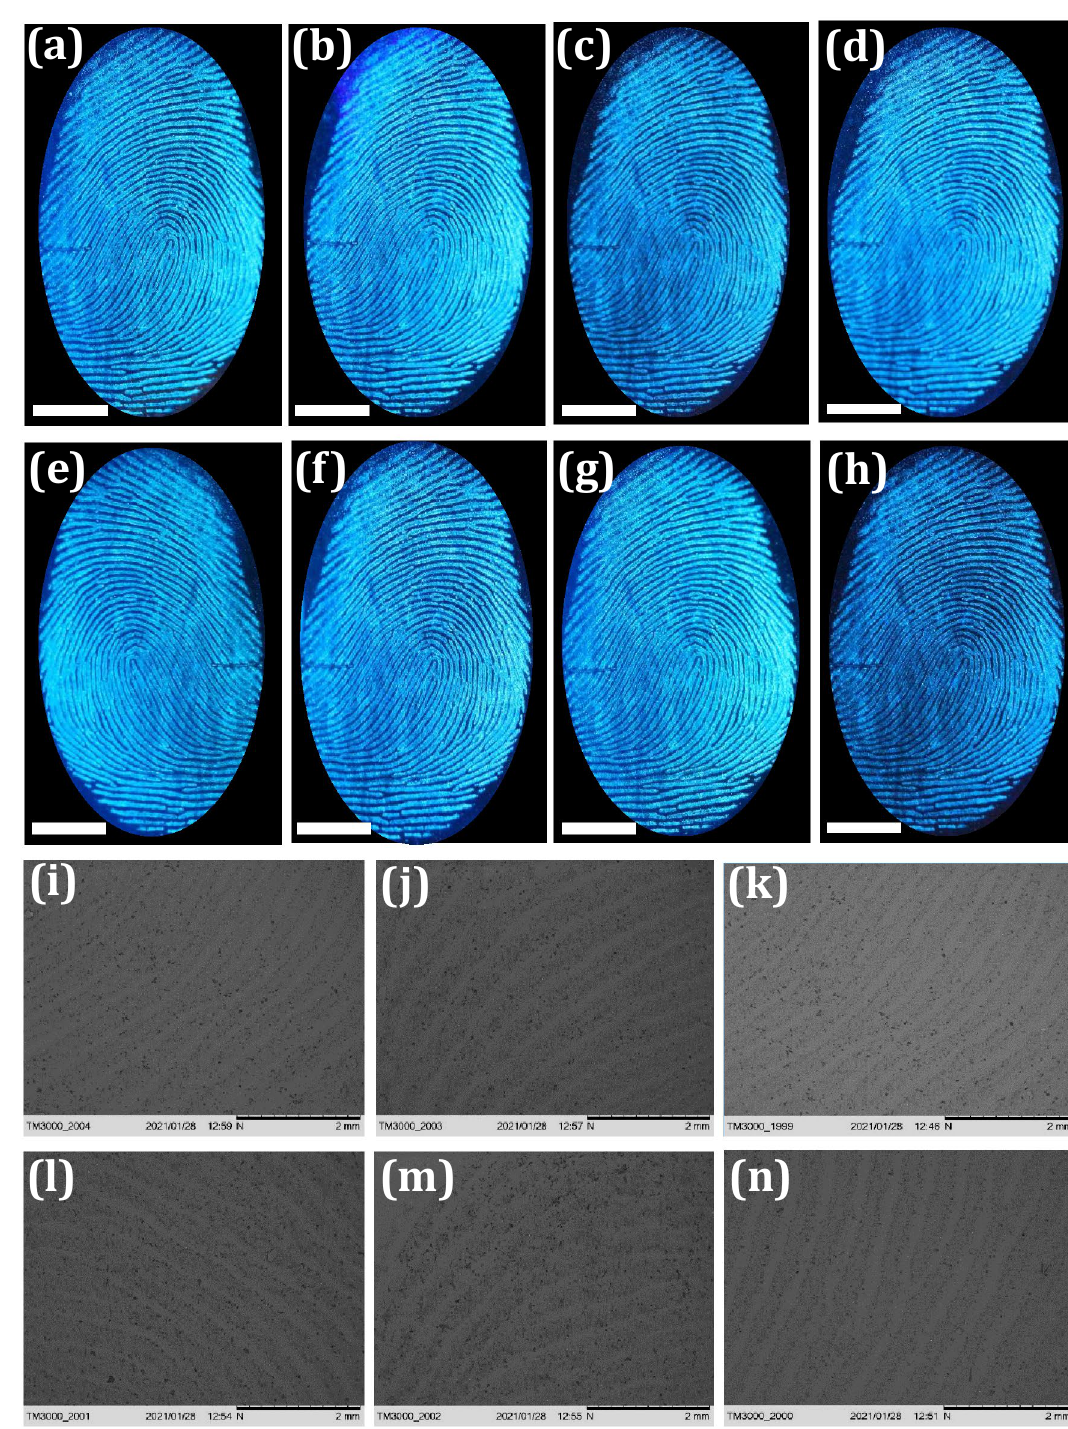
Figure 7. ( a–h ) Fluorescent images of FPs after developing with FDIP solution under UV 365 nm treated with successive physical abrasion. The corresponding grayscale images were shown in Fig. S8 (Scale bar: 5 mm); ( i–n ) SEM images of developed FPs reveal various ridge details demonstrating excellent adhesion of FDIP solution with